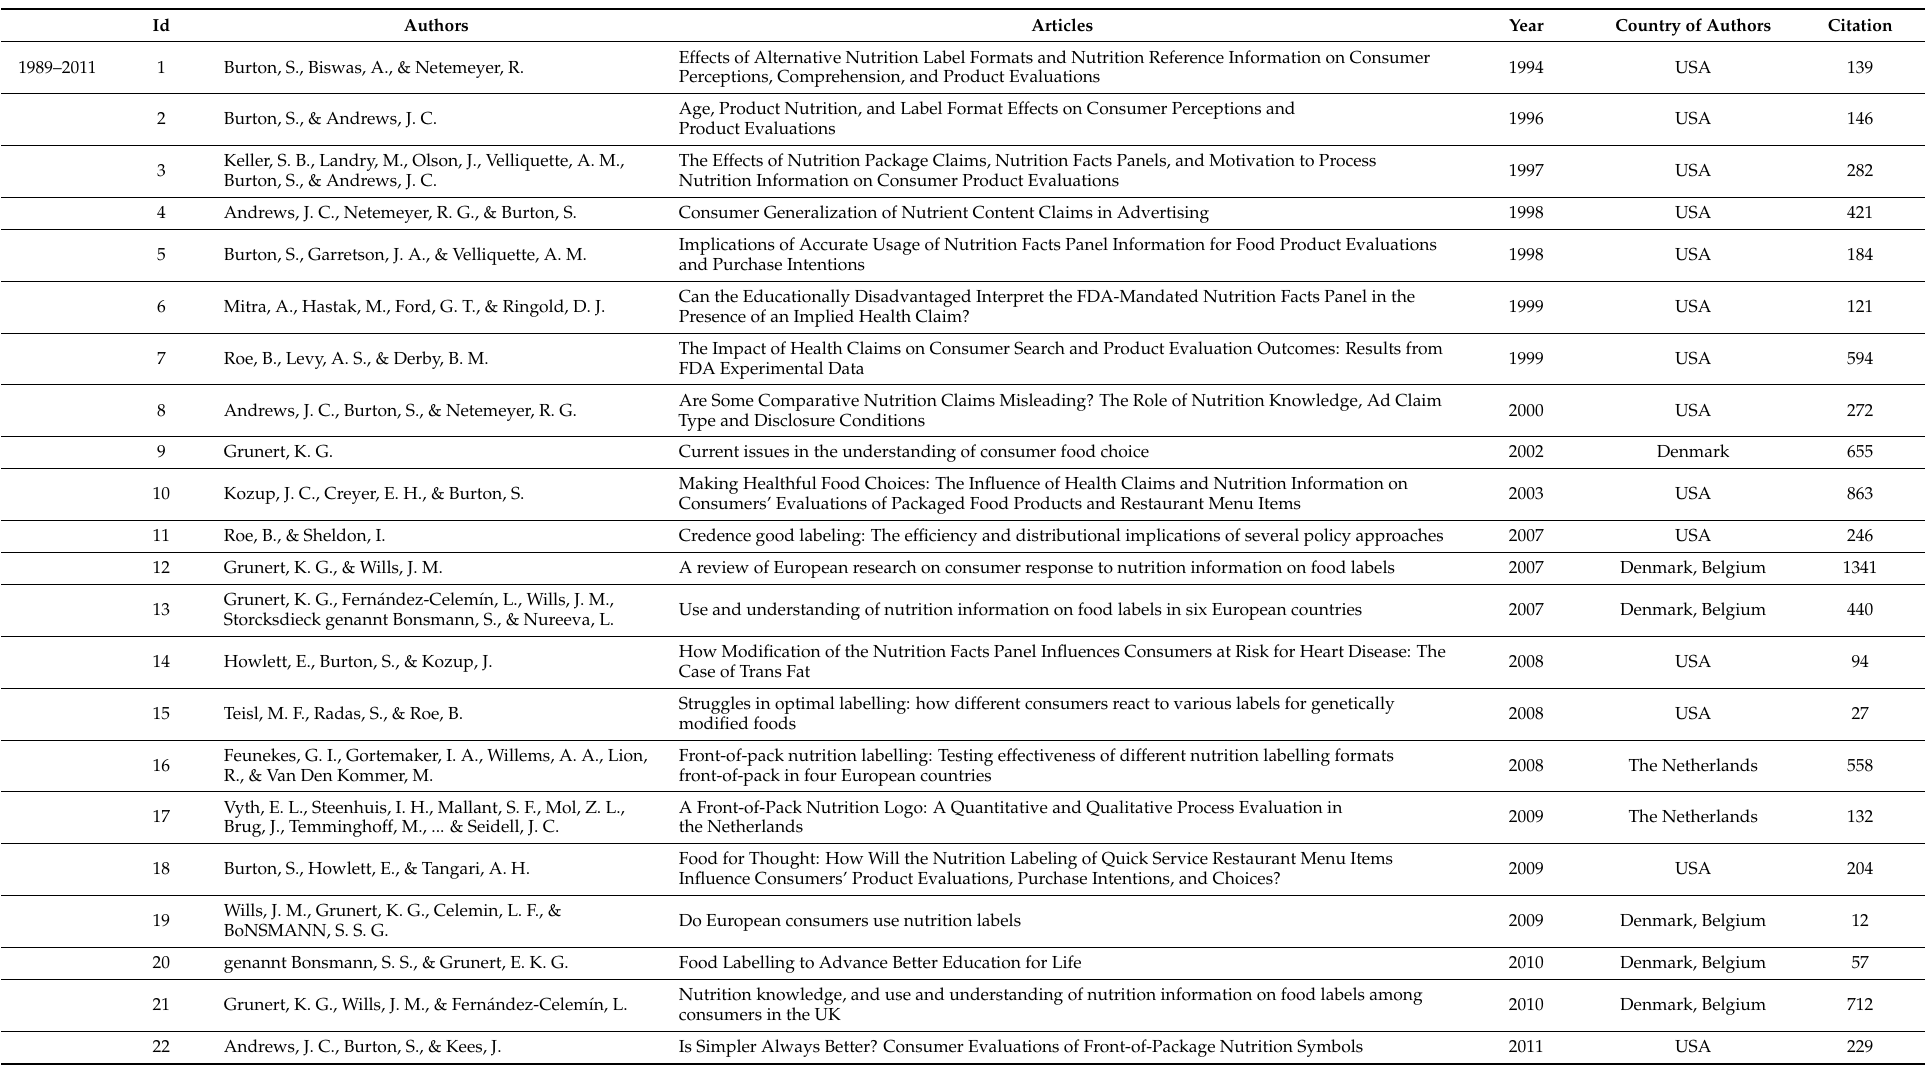
Table 4. Composition of co-citation network 1 in terms of authors, articles, year, country of authors and